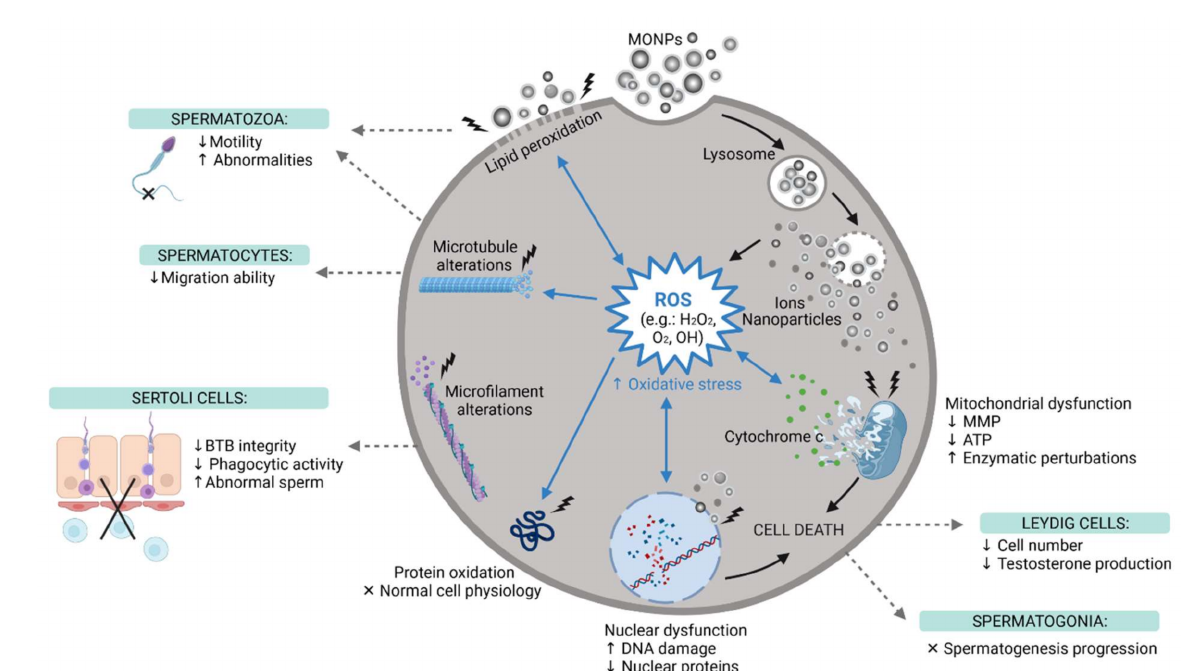
Figure 4. The main reproductive toxic events induced by MONPs at the cellular level. MONPs, Metal Oxide Nanoparticles; ROS, Reactive Oxygen Species; MMP, Mitochondria Membrane Potential; ATP, Adenosine Triphosphate; BTB, Blood-Testis- Barrier; ↑ , increase; ↓ , decrease; x, impaired, created with Biorender.com (accessed on 30 May